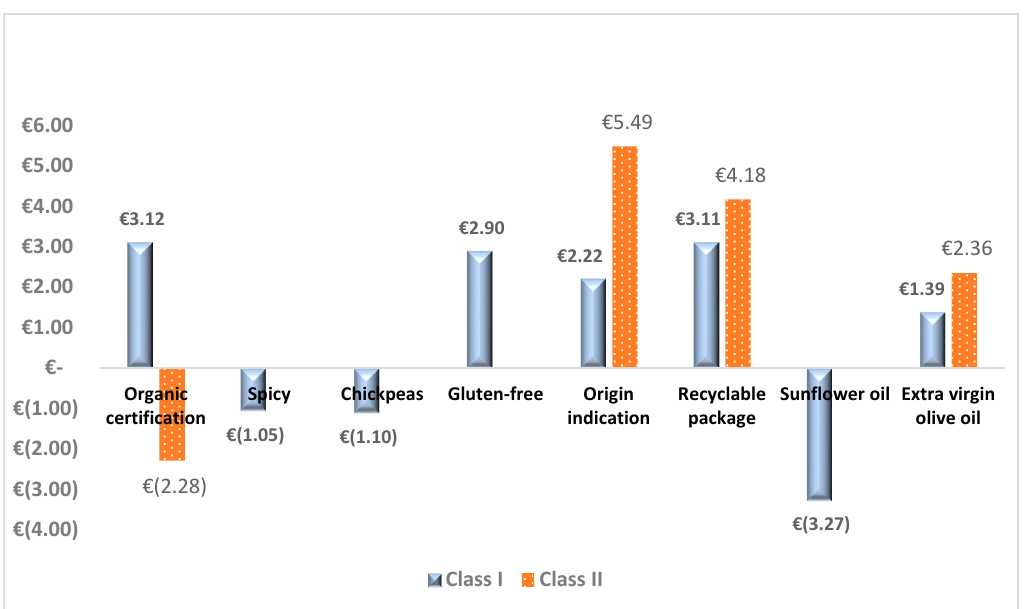
Figure 3. Willingness-to-pay for the use of nutritional ingredients and labelling claims on ready-to-eat legume-based snacks.